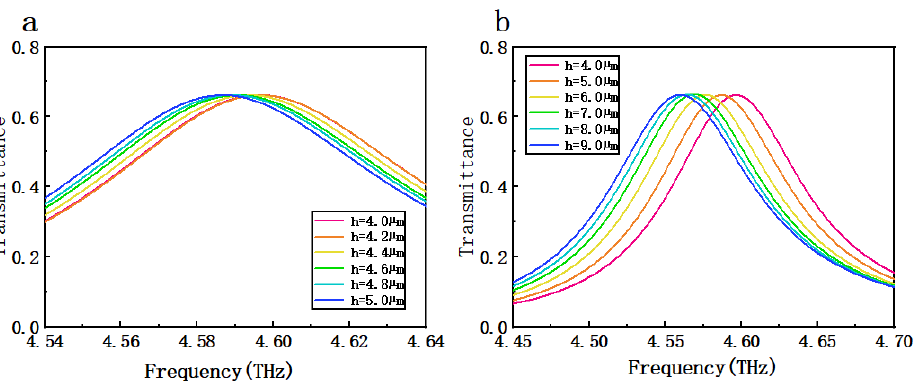
6 of 9 Figure 4. ( a ) The transmittance spectra of d = 7 µm; ( b ) d = 9 µm; and ( c ) d = 11 µm. ( d ) Compari- son of the transmittance of these three hole diameters.